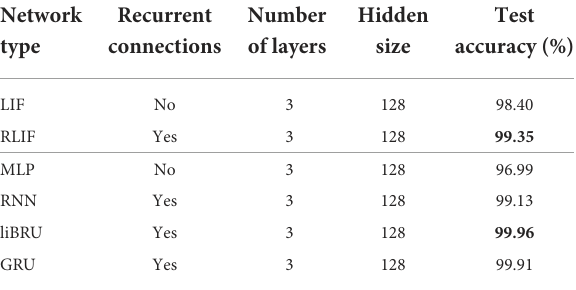
TABLE 5 Results on the SHD dataset. TABLE 6 Results on the HD